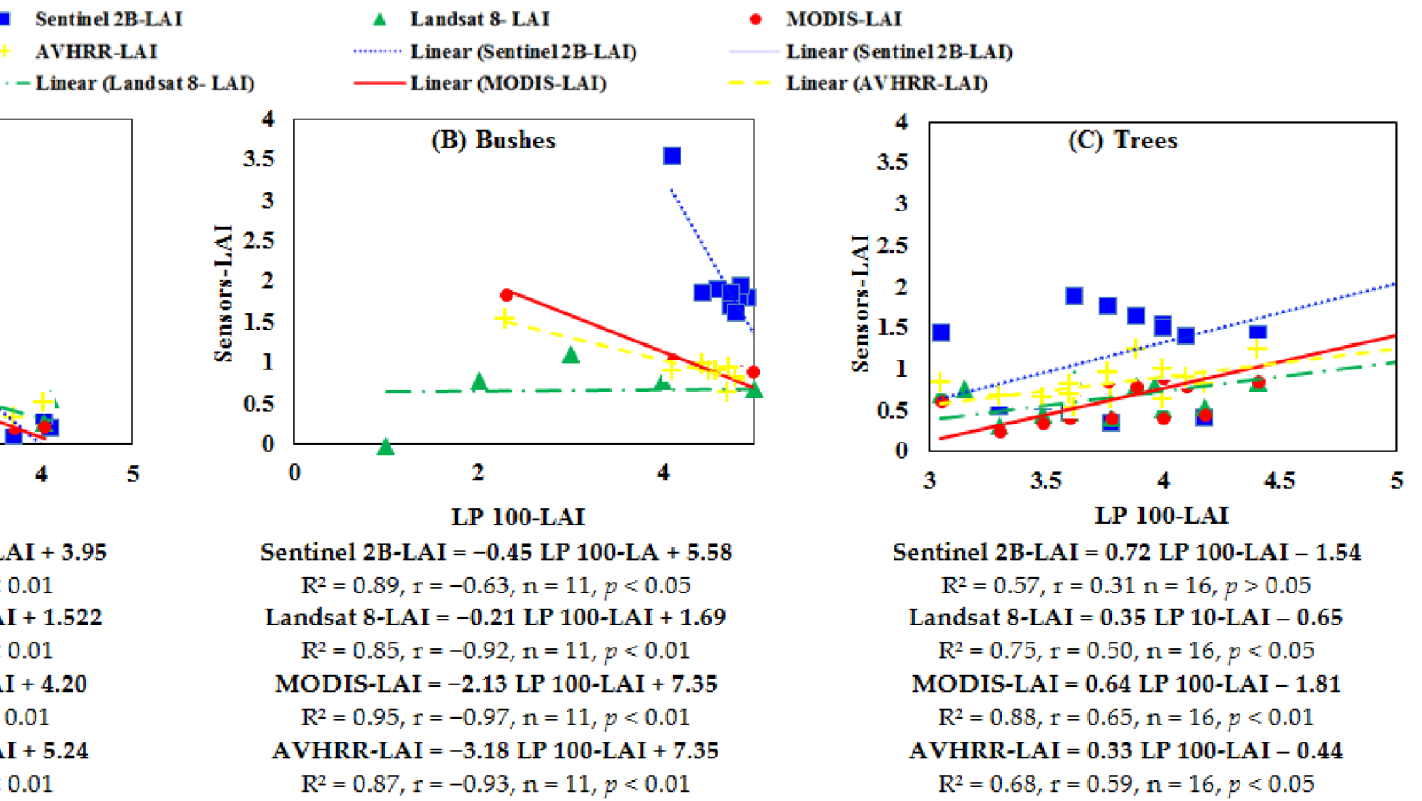
Figure 5. Comparison of LP 100 and estimated LAI in different PFTs: ( A ) shrub, ( B ) bush, and ( C ) tree.